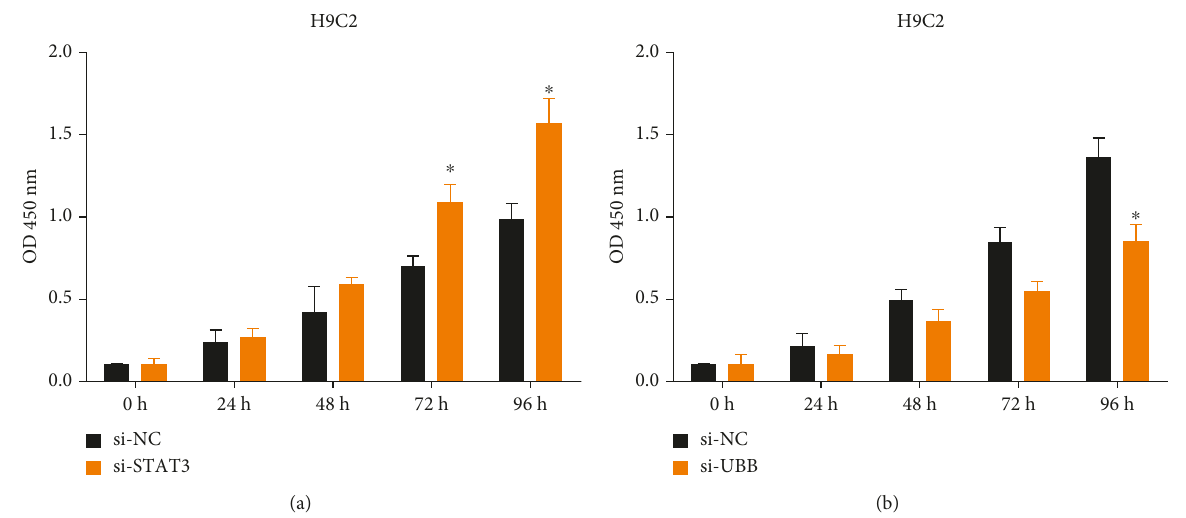
Figure 6: CCK-8 measured the proliferation of the H9C2 cell line. ∗ P < 0 . 05. (a) Cell proliferation experiment graph of downregulation of STAT3 gene. (b) Cell proliferation experiment graph of UBB gene